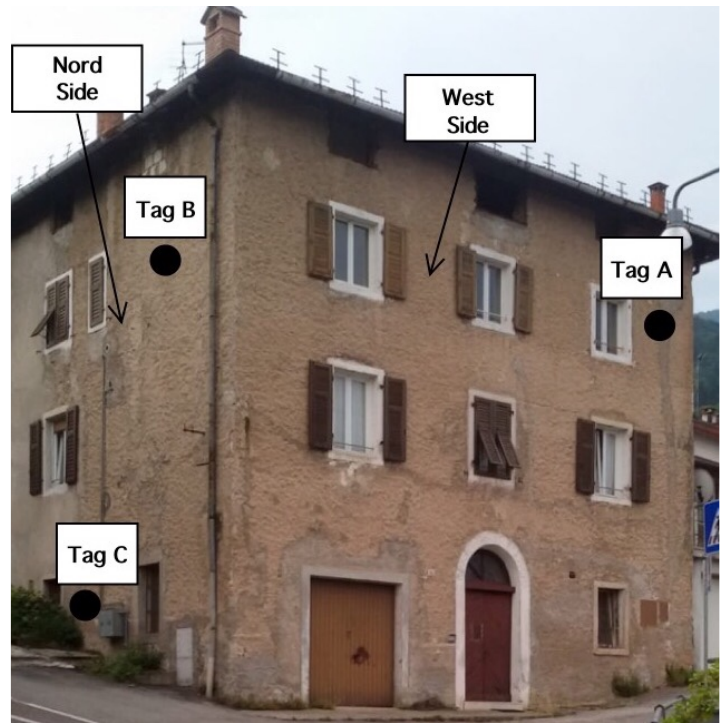
Figure 12. Photo of the considered experimental scenario, a 110 years old building under renovation.